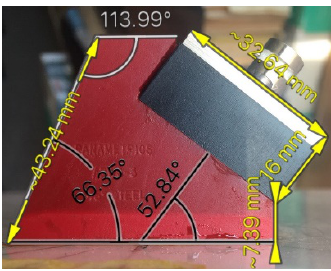
Figure 3. The linear and angular outer dimensions of the used wedge actuator [41].